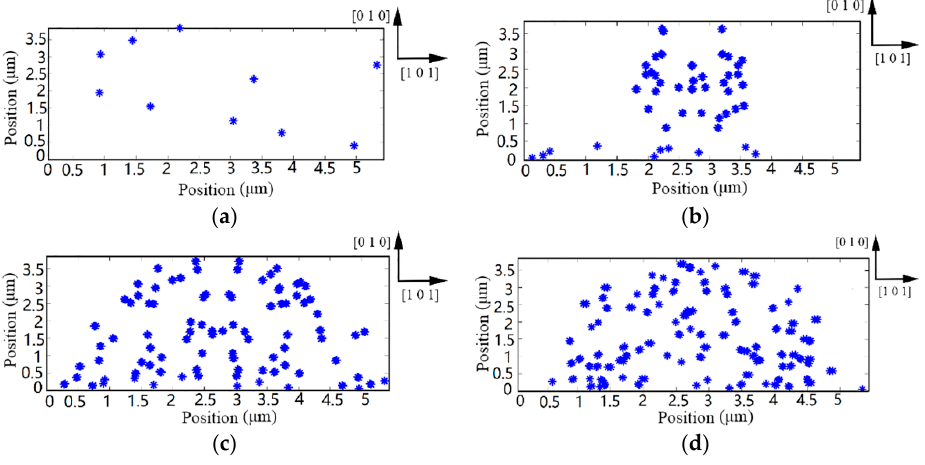
Figure 8. Dislocation patterns of monocrystalline silicon during transient irregular cutting process. ( a ) Dislocation structure at 5 ns; ( b ) dislocation structure at 15 ns; ( c ) dislocation structure at 30 ns; ( d ) dislocation structure at 50 ns.